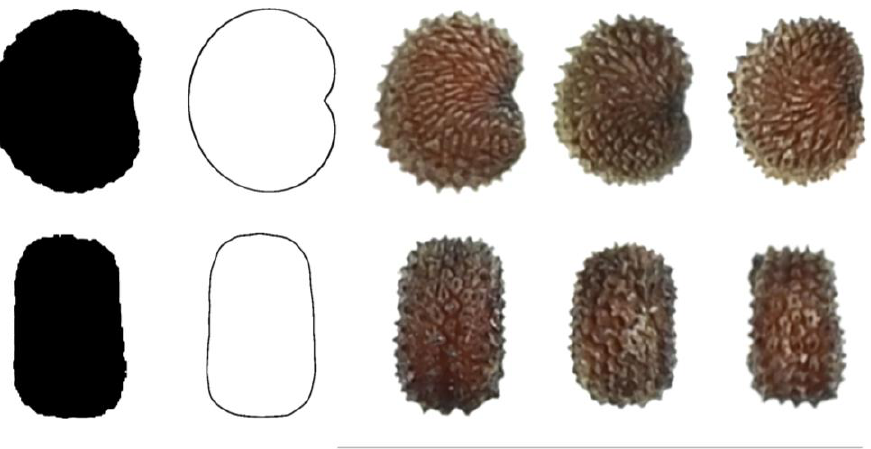
views. Bar represents 1 mm.